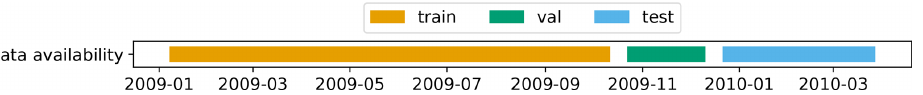
Figure 2. Data availability and split into training (orange), validation (green) and testing (blue) data sets. Each day contains data from all 332 pseudo-stations.